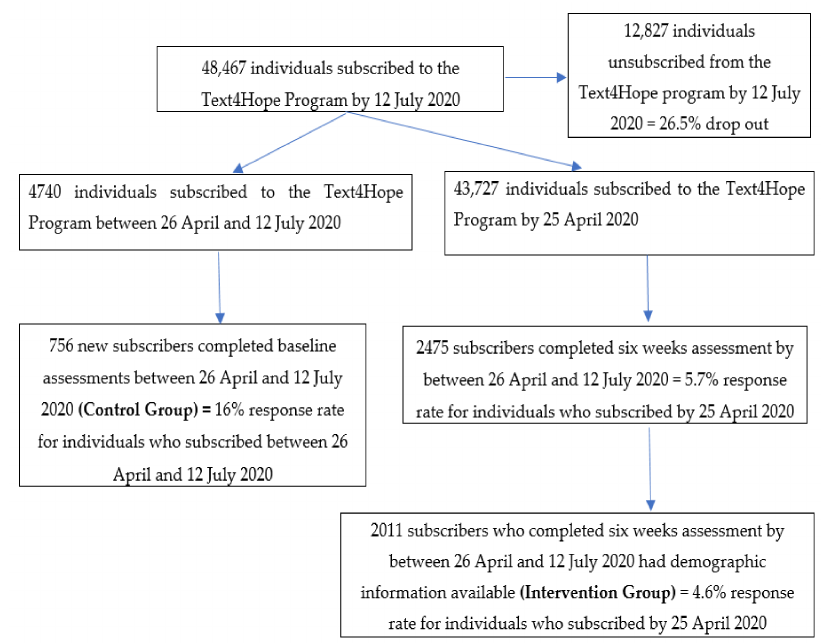
Figure 1. Subscriber flowchart as of 12 July